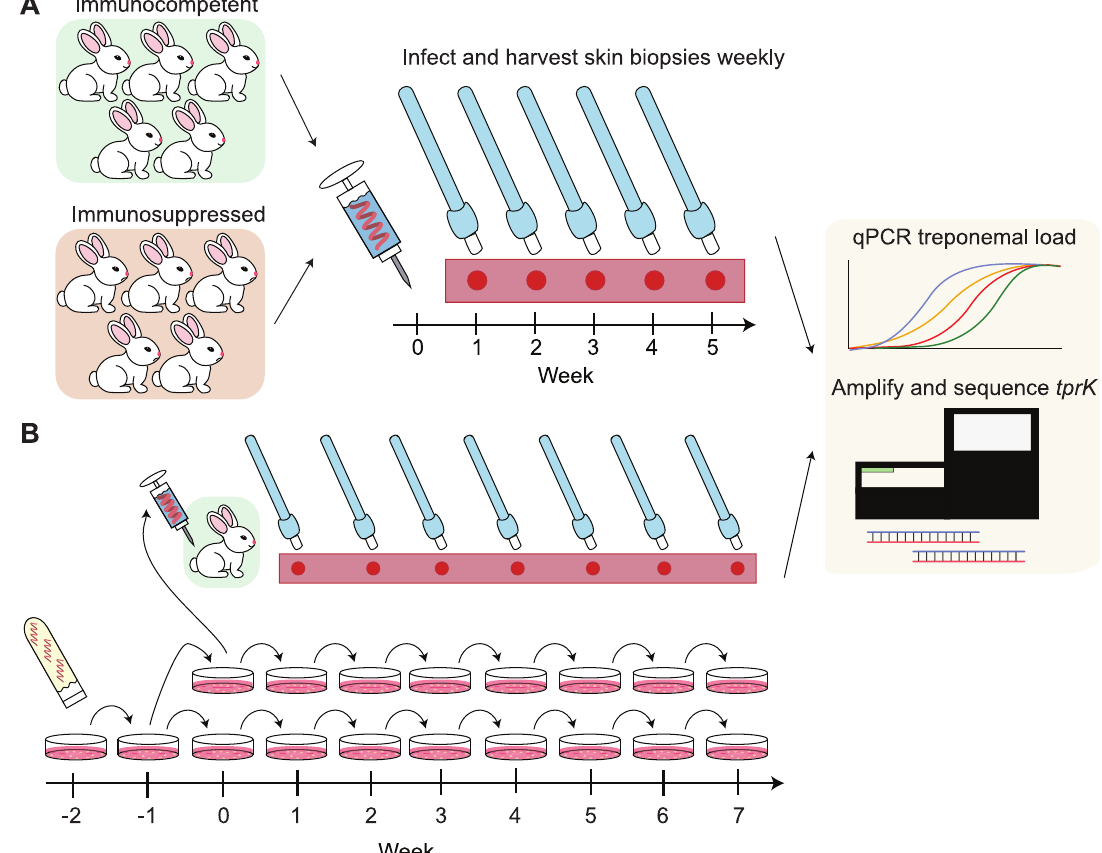
Fig 2. Study design for sample acquisition from (A) immunosuppressed vs. immunocompetent rabbits and (B) in vitro propagated treponemes vs. control. (A) Five immunocompetent rabbits and five immunosuppressed rabbits were infected with inoculum at Week 0. Harvesting of punch biopsies from each rabbit was done weekly for 5 weeks. Samples were analyzed for treponemal load by qPCR and tprK sequence by next-generation sequencing. (B) Glycerol stock of T . pallidum Chicago C was thawed at Week -2, passaged in vitro at Week -1 and again at Week 0, at which point treponemes were 1) inoculated intradermally into a control rabbit, and 2) seeded into two sets of weekly-passaged cultured samples for 7 weeks. Samples were collected weekly from punch biopsies of the rabbit and from cell culture, then analyzed for treponemal load and tprK sequence.